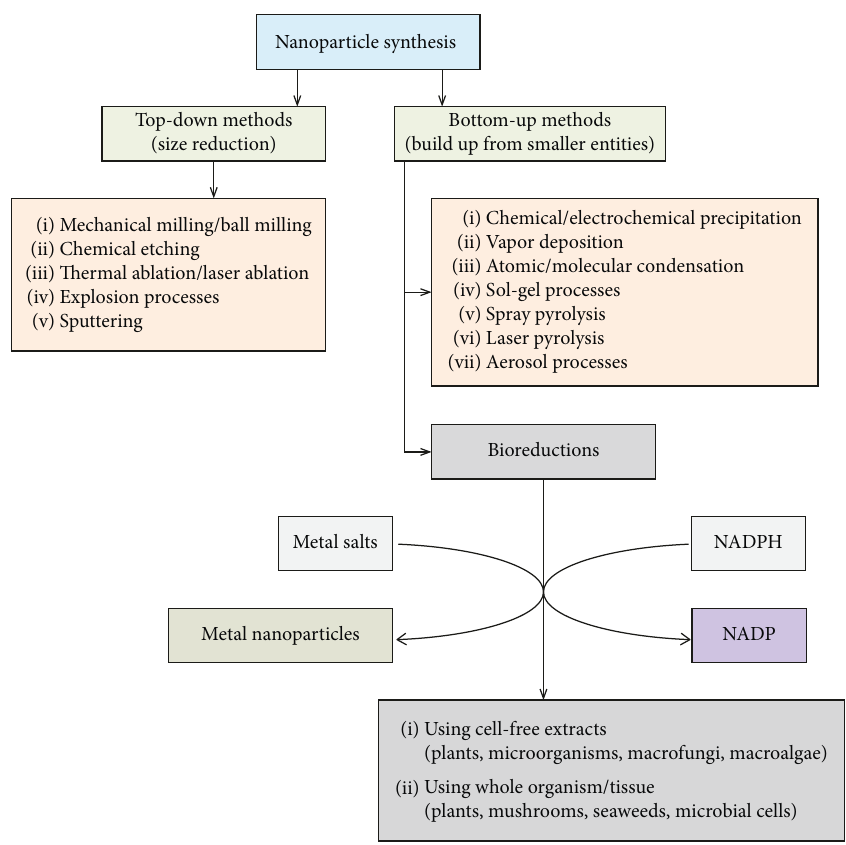
Figure 4: Production of nanoparticles